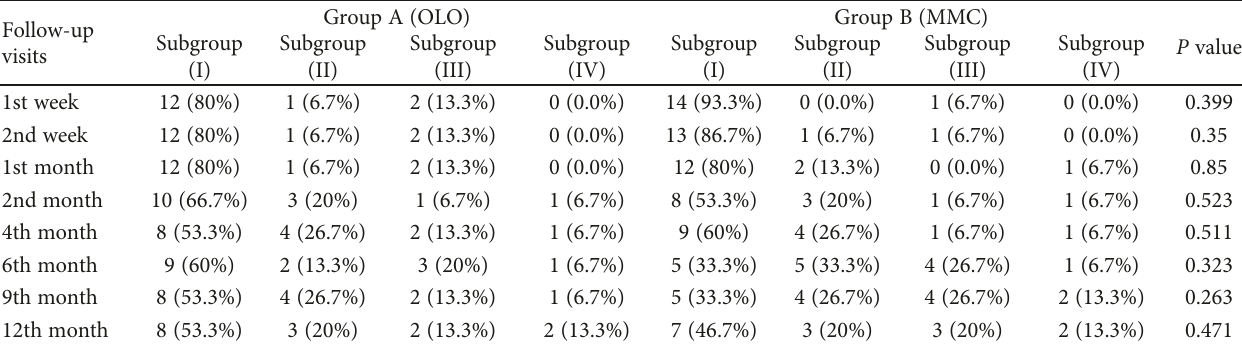
Table 1: Results of IOP during the follow-up period in both groups.